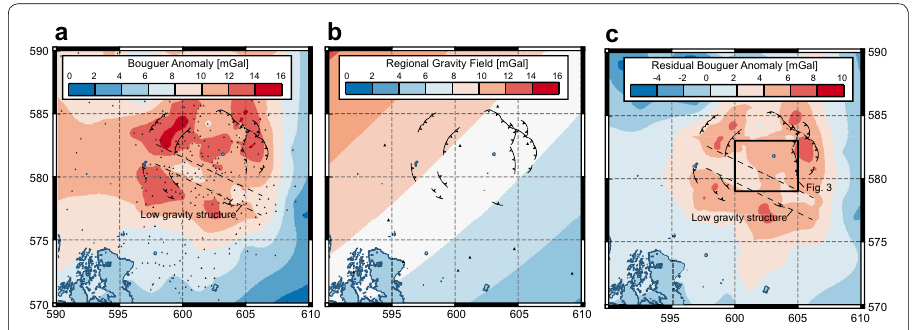
Fig. 2 Bouguer gravity map of the Krafla area. a Bouguer anomaly. b Regional gravity field. c Residual Bouguer anomaly calculated by subtracting b from a . Measurement stations shown as grey dots. Caldera faults and boundaries of WNW–ESE-oriented low gravity structure shown with dashed line (see